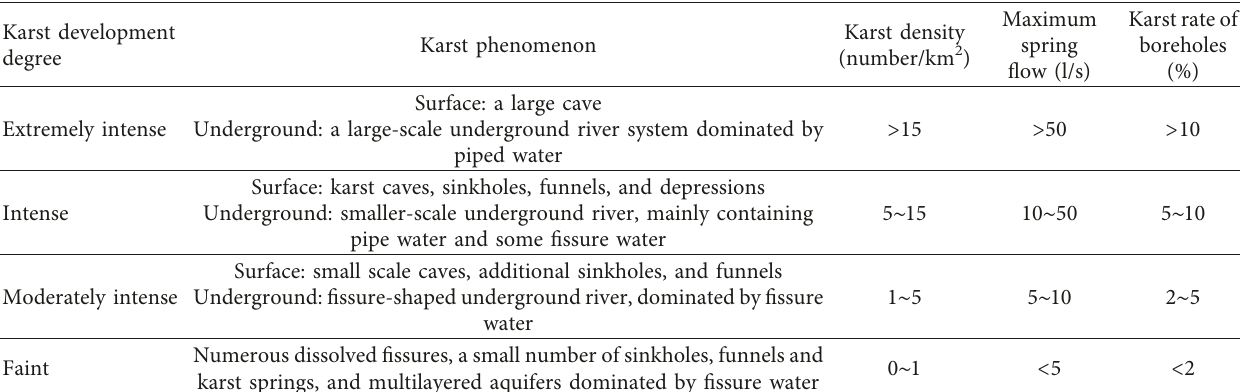
Table 2: Karst development degree characteristics and